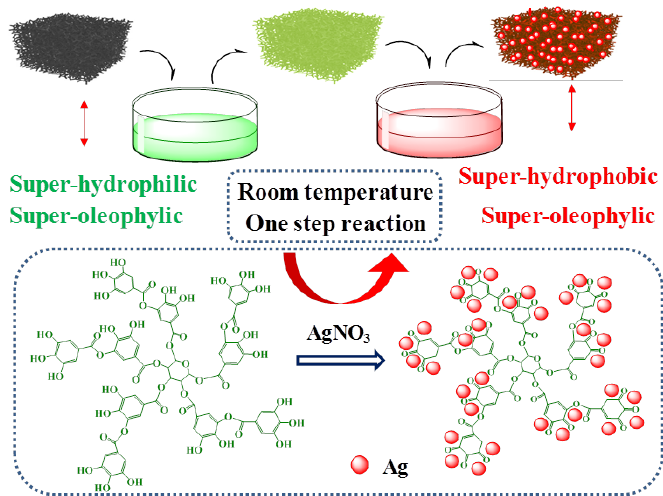
Figure 1. Schematic of the preparation process of superhydrophobic